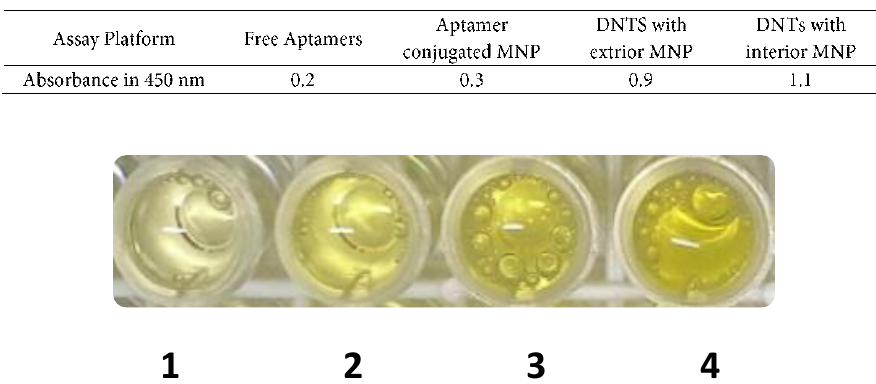
Fig. 8. Comparison of colorimetric assessment of insulin detection in conjugated and non-conjugated mode. 1) aptamer in non-conjugated mode , 2) Aptamer conjugated MNP, 3) Aptamer conjugated DNTs with extrior alignment of MNP on the surface, 4) Aptamer conjugated DNTs with interior alignment of MNP in central channel of DNTs. In all wells, all the reactive factors such as insulin concentration and the recognition element are considered identical..